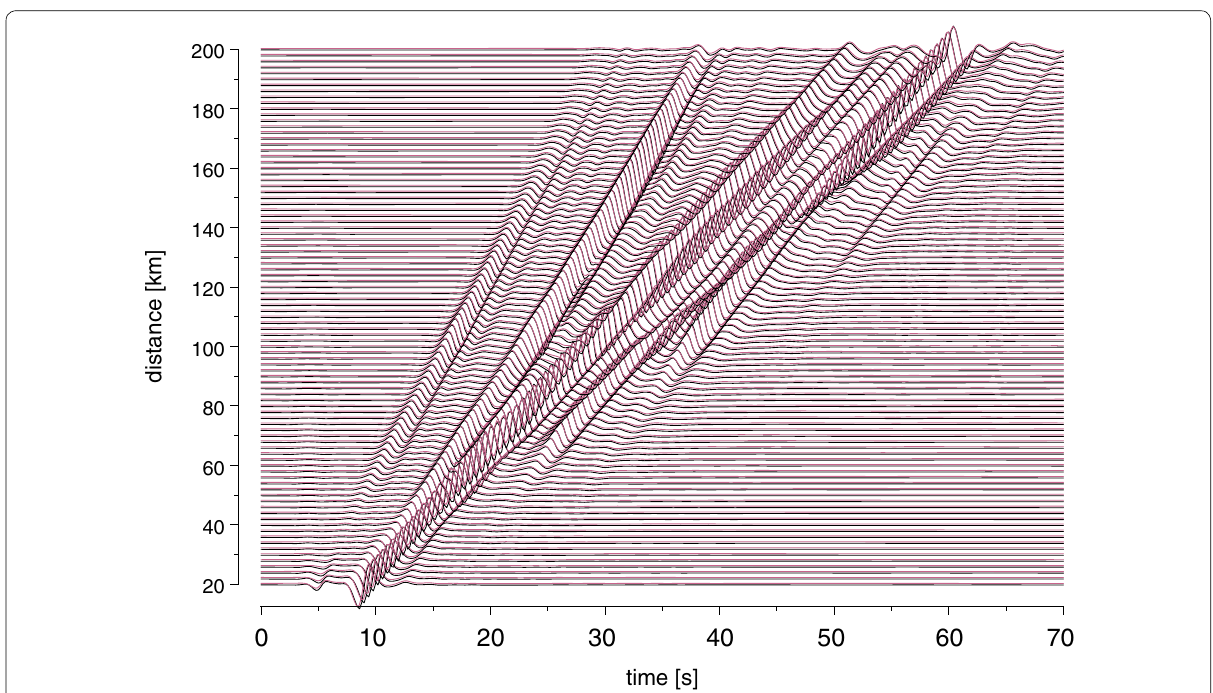
Fig. 10 Comparison of vertical-component velocity seismograms obtained by the frequency–wavenumber integral method of Saikia (1994) ( black curve ) and OpenSWPC ( red curve ) in the frequency range of 0.01–0.5 Hz under the laterally homogeneous structure of Kubo et al. (2002). The ampli- tude at each distance is normalized by the maximum amplitude of the trace obtained by the frequency–wavenumber integral method. Note that the two traces at the same distance are slightly shifted vertically so that they do not